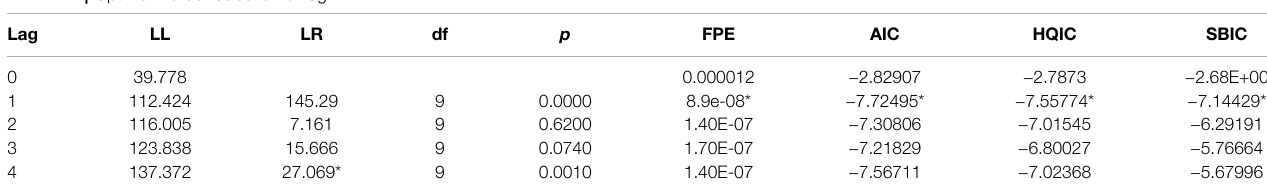
TABLE 4 | Optimum order selection of lag.